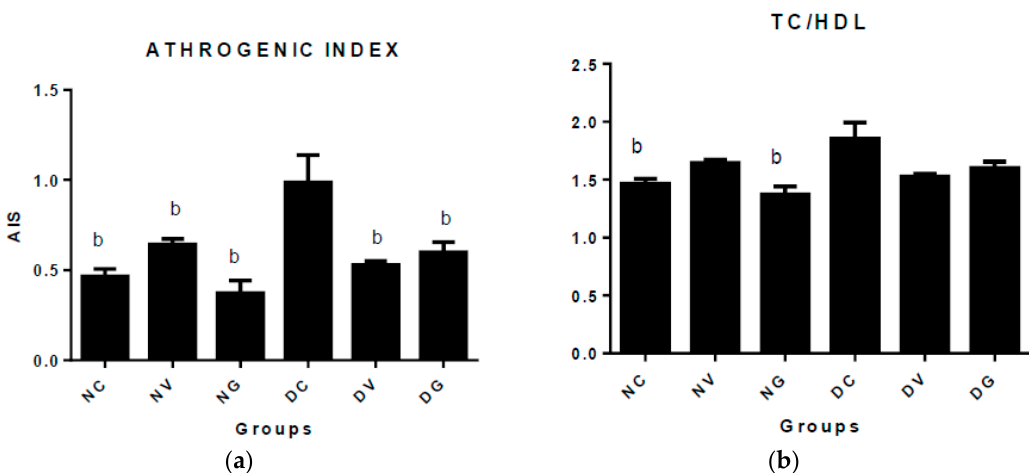
Figure 2. Atherogenic index assessment after 6-week treatment period ( a and b ). Data represented as